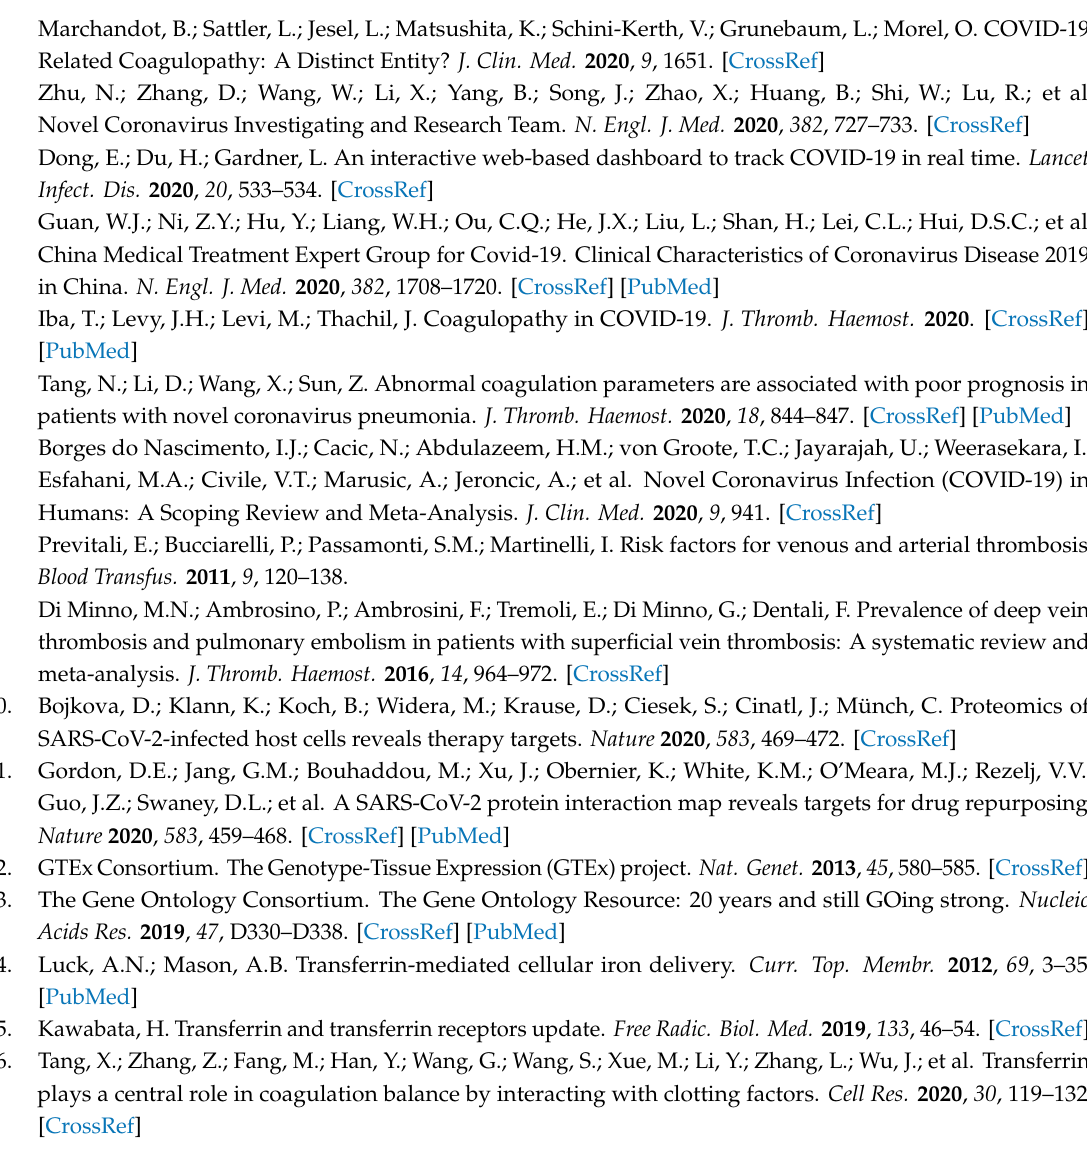
Table S1: Genes associated with the GO term “Blood Coagulation” (GO:0007596) in males vs. females title, Table S2: Correlation of the expression of coagulation-associated genes with age, Table S3: Genes with relevant functions whose expression levels correlate with age and di ff er between males and females, Table S4: Genes di ff erentially regulated in SARS-CoV-2-infected Caco2 cells, Table S5: Interaction partners of SARS-CoV-2